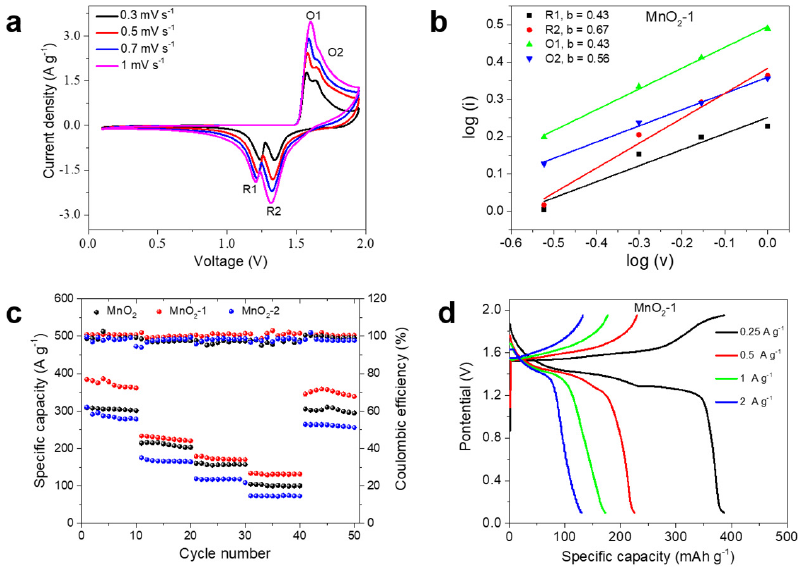
Figure 5. ( a ) CV curves of the Zn/MnO 2 ‐ 1 battery at various scan rates over the potential range of 0.1–1.95 V; ( b ) a linear fit of log(i) as a function of log(v); ( c ) rate performances of the three